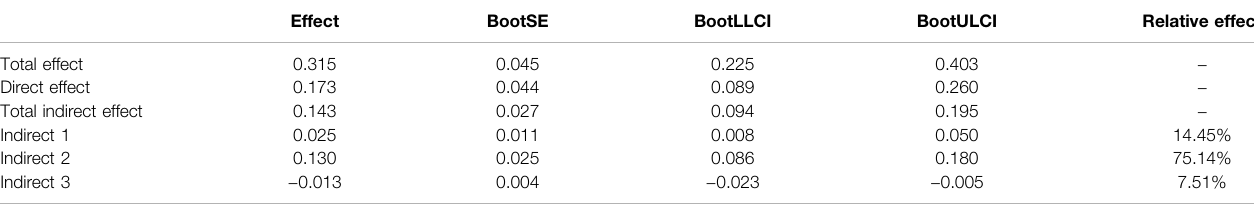
TABLE 3 | Multiple Mediating Effects Test of information overload and attitude between information complexity and behavior intention.